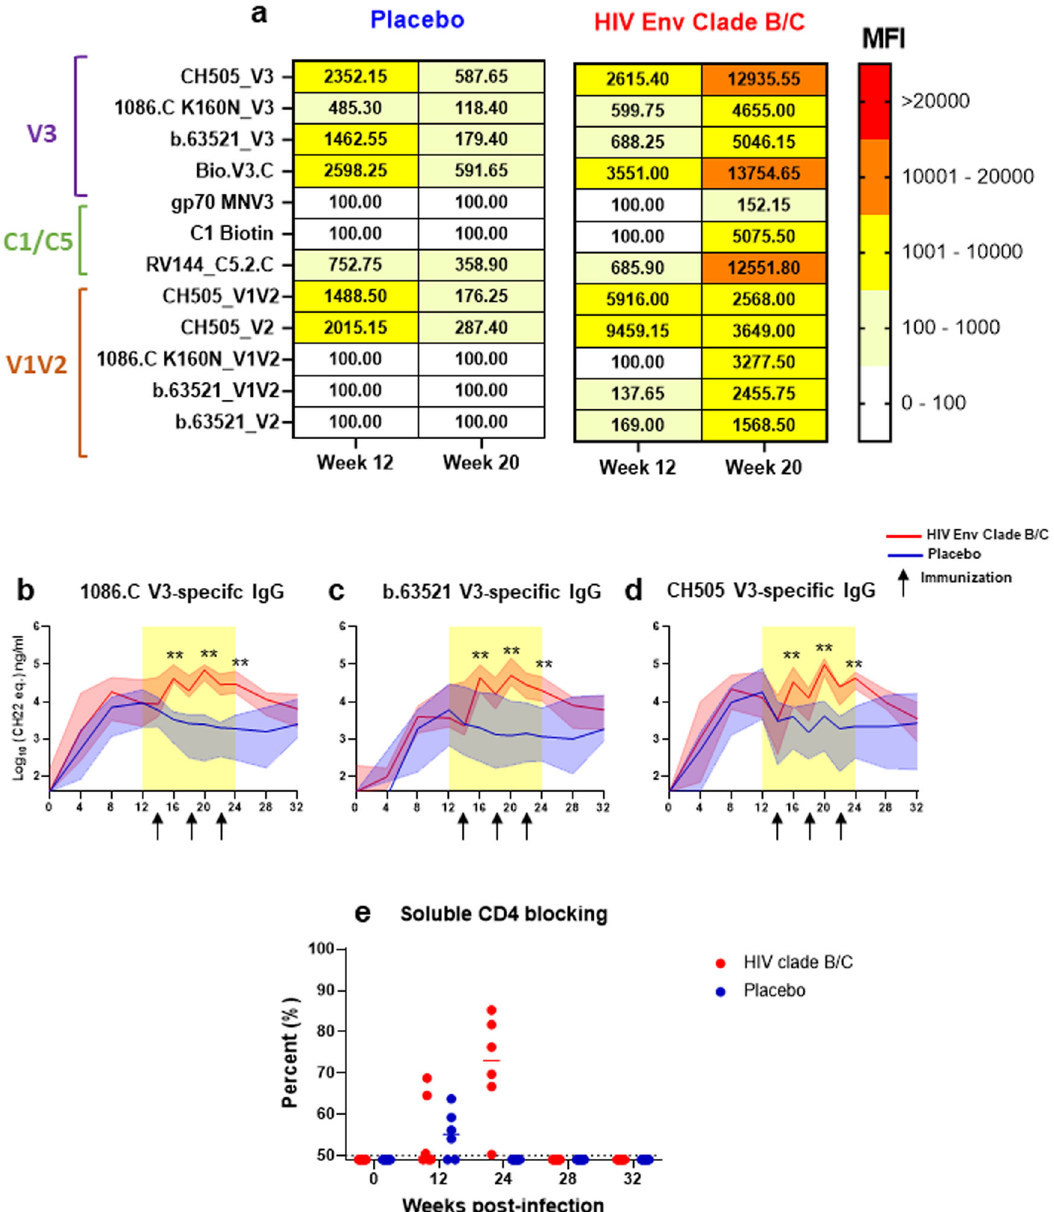
Fig. 3 Epitope speci fi city of Env-speci fi c IgG responses. Plasma IgG speci fi city to a panel of HIV Env linear and conformational epitopes at pre-ART/immunization, week 12, and at peak IgG binding, week 20 post-infection ( a ). Data shown are median MFI for each antigen. Level of V3-speci fi c IgG binding against vaccine ( b , c ), and challenge virus antigen ( d ) measured by quantitative ELISA. Bold lines represent the median, and the range is depicted by the shaded area. Black arrows indicate time points at which immunizations were administered (14, 18, and 22 wpi). Statistical analyses were performed using Wilcoxon rank-sum tests with exact p -values to compare V3-specifc IgG responses between vaccinated and placebo RMs, followed by FDR adjustments for multiple comparisons. **unadjusted p < 0.01. e Plasma blocking of soluble CD4- 1086.C gp120 interactions. Each dot represents one animal, and medians are represented by horizontal